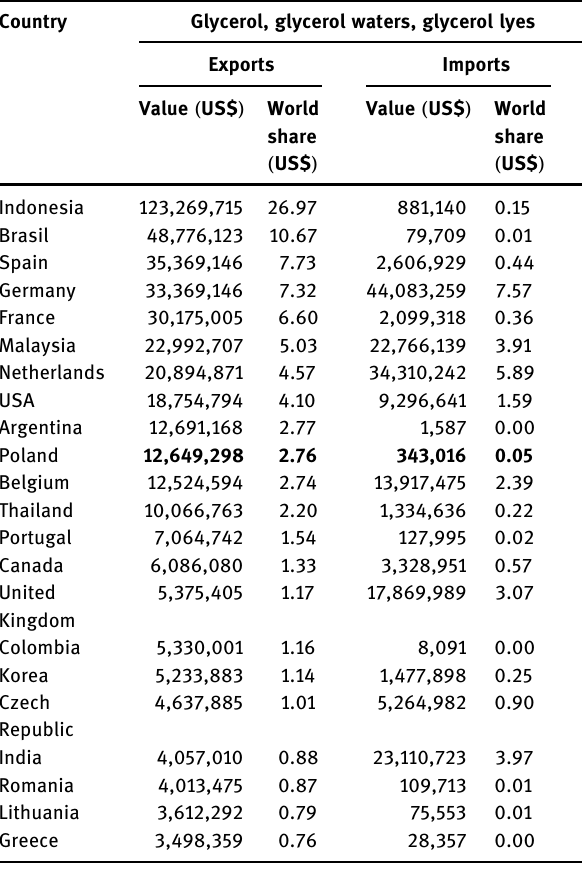
Table 3: Import and export of glycerol in the world ( chosen country ) in 2019 [ 115 ]